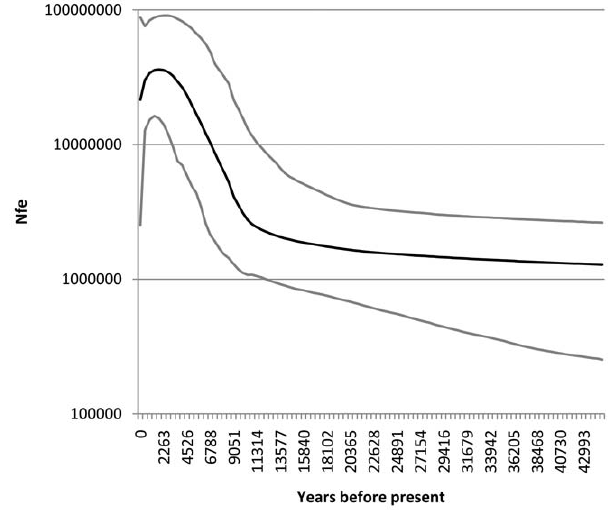
Figure 7. Bayesian skyline plot of historical female effective population size, light lines represent the 95% highest poste- rior probability density around the estimate.